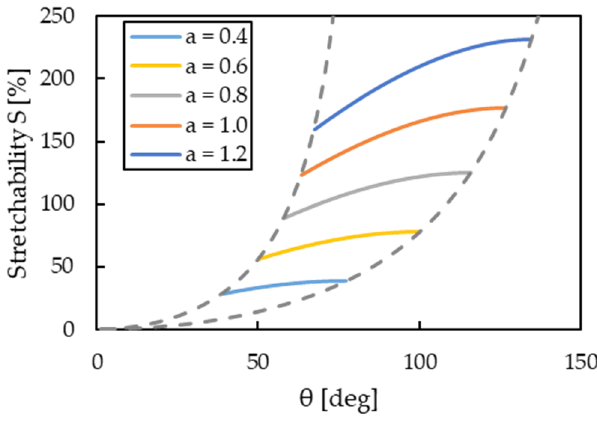
Figure 5. Graphical illustration of Equation (6).